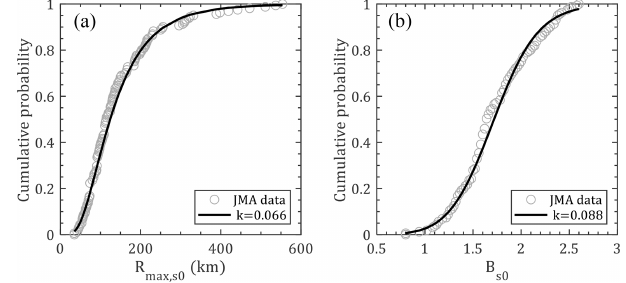
Figure 8. CDFs of wind field parameters at first step: (a) R max , s0 ; (b) B s0